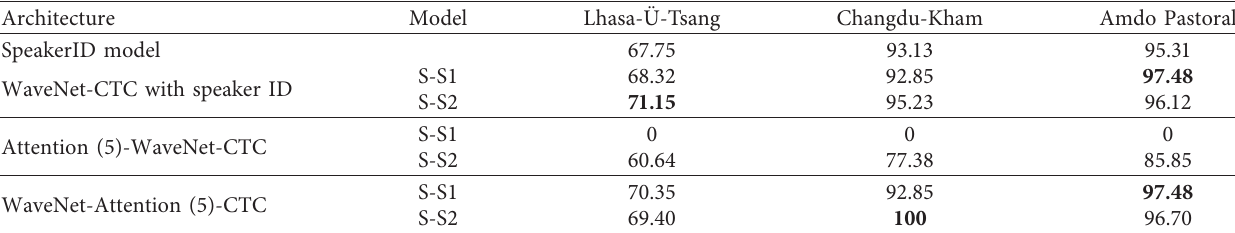
Table 4: Speaker ID recognition accuracy (%) of two-task models.